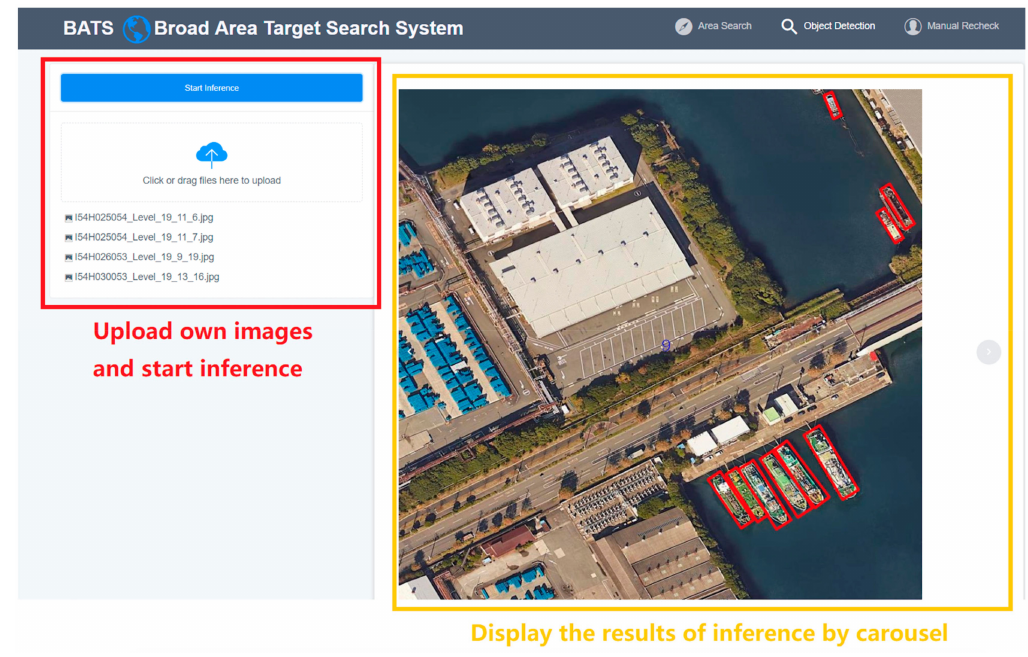
Figure 13. The interface of the target detection module for an independent